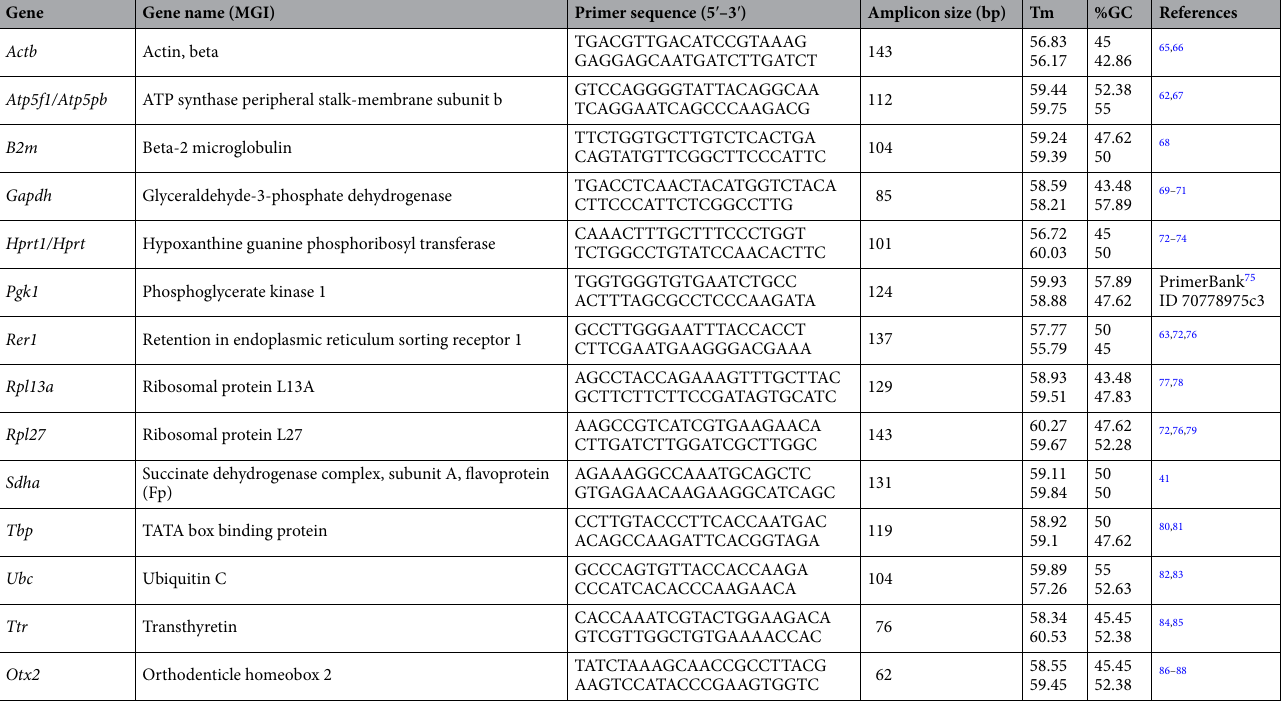
Table 1. Summarized information of 12 candidate reference genes and 2 target genes. Tm: melting temperature (calculated by NCBI Primer-Blast with default settings for Primer